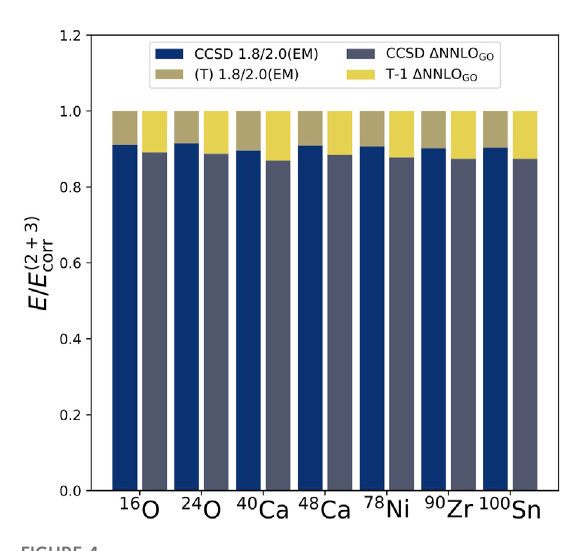
FIGURE 4 Relative contributions to the correlation energy E ( 2 + 3 ) corr of several closed-shell nuclei from coupled cluster with singles and doubles (CCSD) and triples using the CCSD(T) approximation for the 1.8/2.0 (EM) interaction of Ref. [67] (left bars) and CCSDT-1 for the Δ NNLO GO (394) interaction of Ref. [65] (right bars). The CCSD result accounts for about 90% of the correlation energy for different nuclei and interactions, and this visualizes the systematic improvements of the coupled-cluster expansion. The data is taken from Ref.